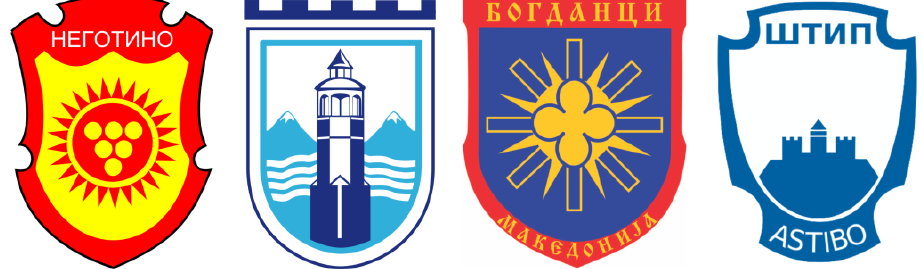
Figure 7. Sample of heraldic arms: Centar, Arachinovo, Gjorche Petrov, and Bitola.